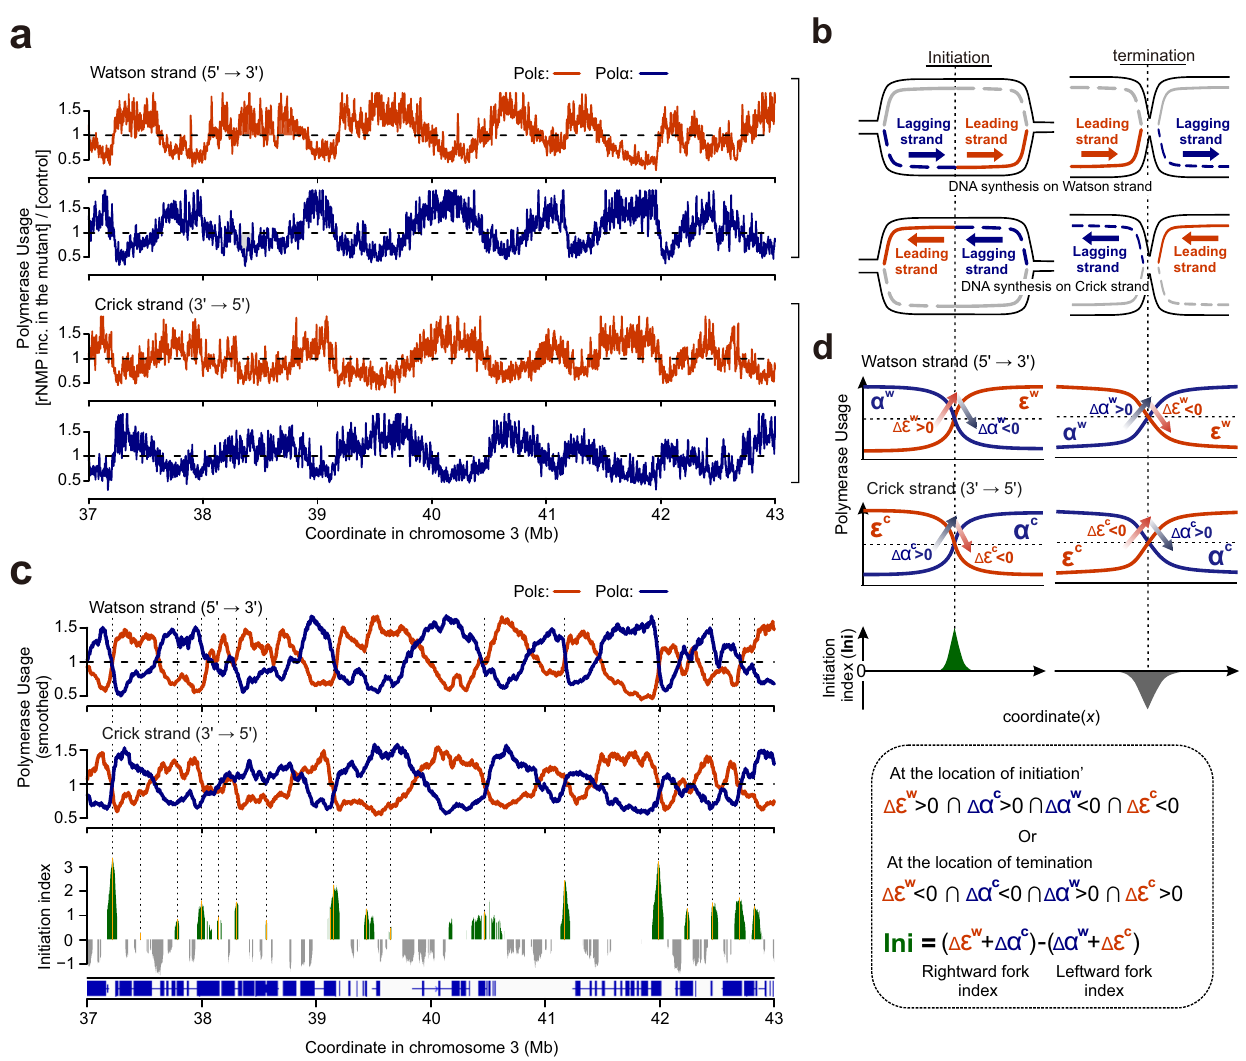
Fig. 2 | Polymerase usage and replicationinitiationacross thehumangenome. a Pro fi les of the relative reads for Pol ε and Pol α mutants on the Watson and Crick strand for each 1kb bin. Orange: Pol ε (POLE1-M630F). Blue: Pol α (POLA1-Y865F).A representative region of chromosome 3 is shown. Data were smoothed with a moving average ( m =3; see “ Materials and Methods ” ). b Schematic representation ofpredictedPol ε andPol α pro fi lesatasiteofreplicationinitiationandtermination. Orange: leading strand. Blue: lagging strand. c Top: smoothed data from panel a